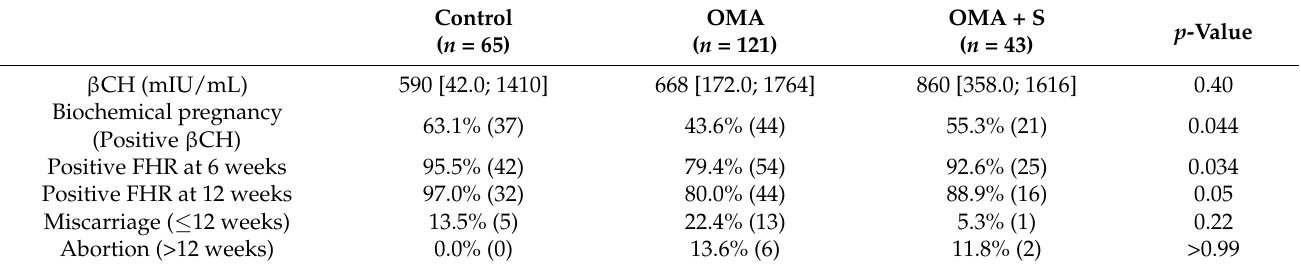
Table 3. Pregnancy outcomes between women undergoing IVF with and without